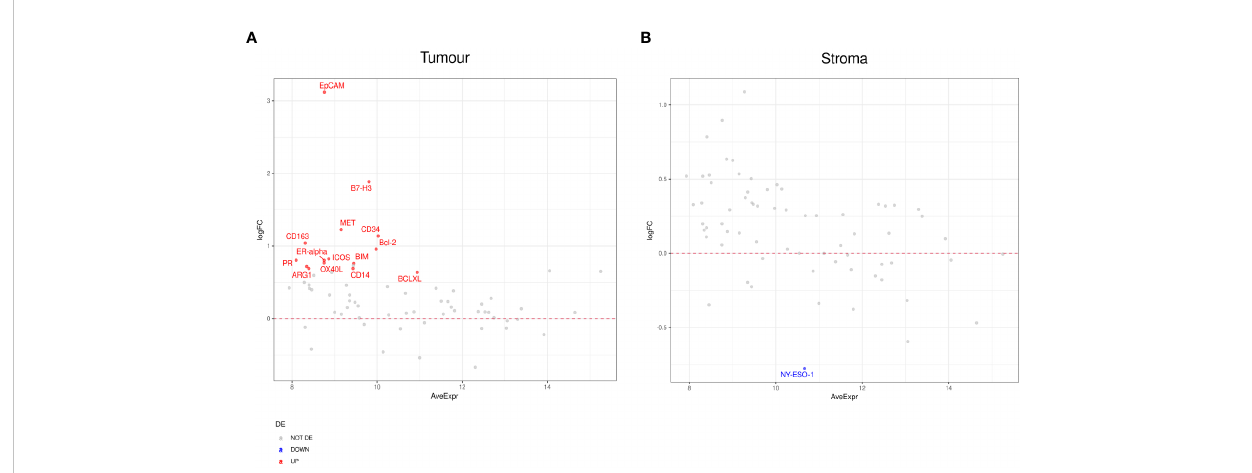
FIGURE 5 Differential protein expression between patients with stable disease (SD) (n=3) and progressive disease (PD) (n=8). (A, B) MA plots of Mean Expression (AveExpr) vs fold change (logFC) visualizing expression of protein biomarkers in patients with SD compared to patients with PD for (A) tumor samples or (B) stromal samples. Colors denote not differentially expressed markers (gray), signi fi cantly up- (red) and down-regulated (blue) markers based on false discover rate (FDR) < 0.05 after multiple comparison testing.